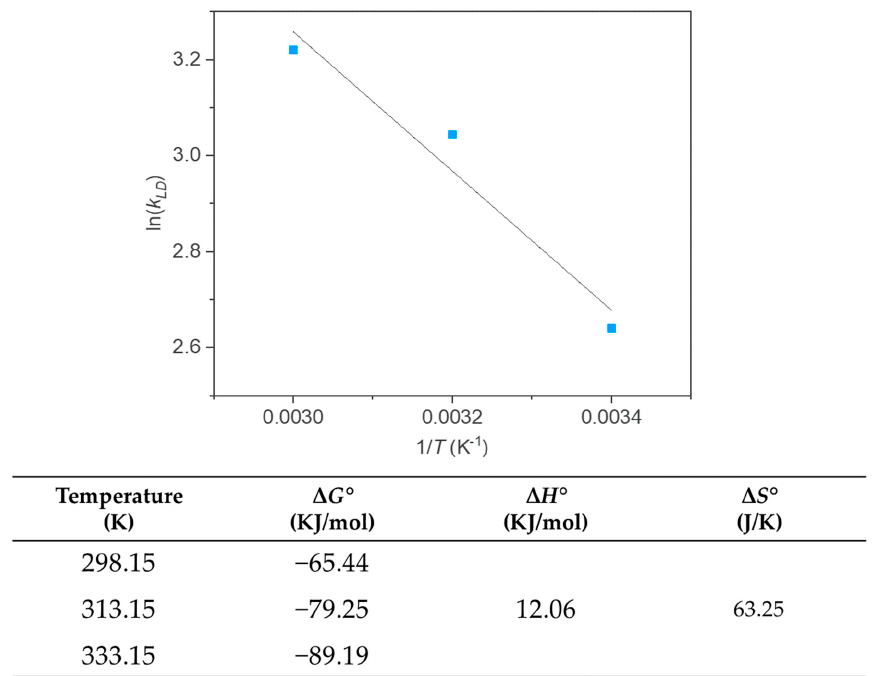
Figure 6. Van’t Ho ff plot for phenols adsorption from OMW. The calculated values from Equation (7) are reported in the table.